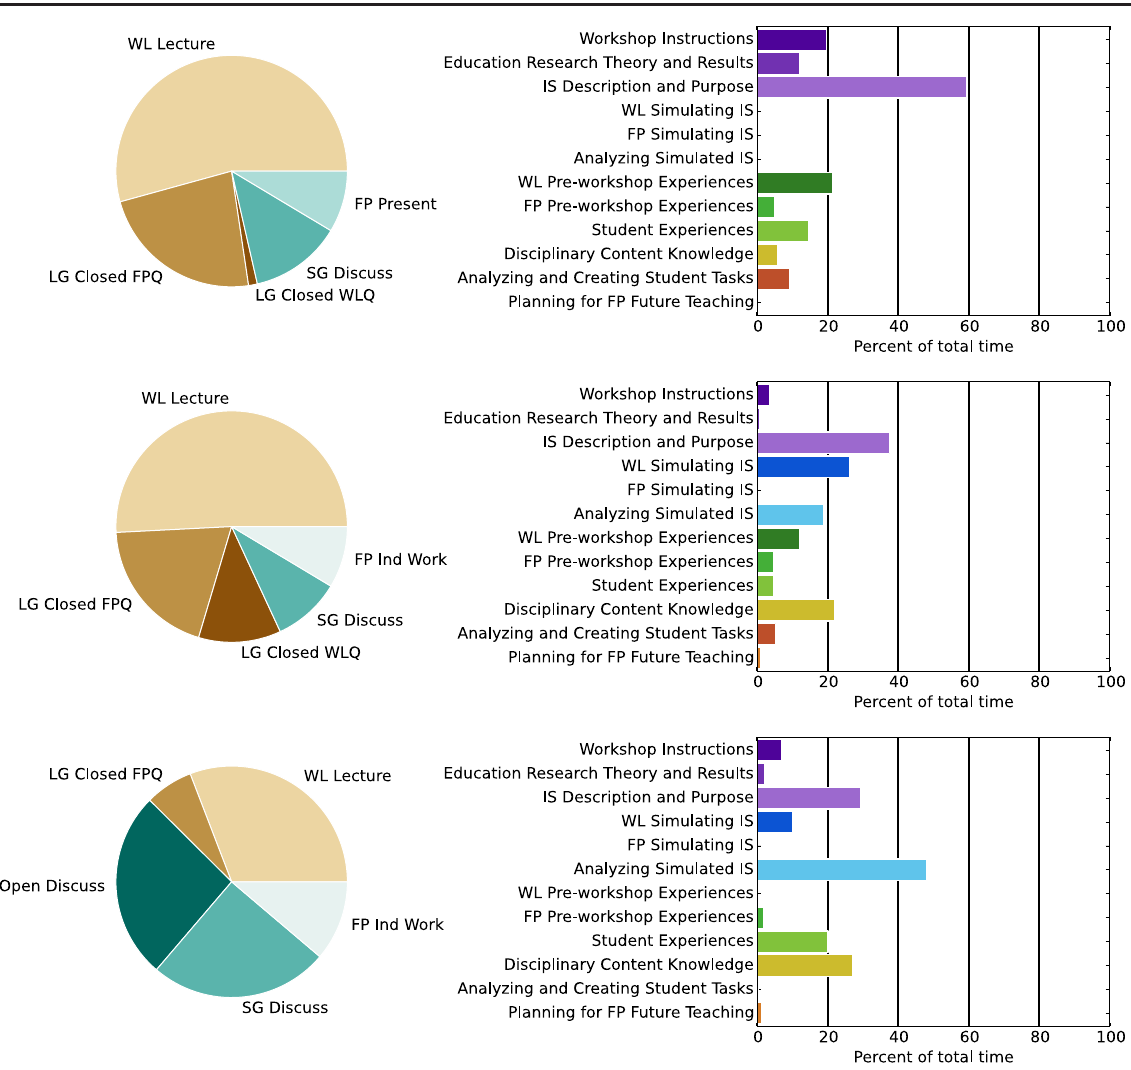
FIG. 2. Summative plots showing how much time was spent enacting each R-PDOT code during three approximately 1-h long sessions of the Physics and Astronomy New Faculty Workshop, labeled A , B , and C . The pie charts show the type of faculty ’ s engagement as defined in Table I, where authoritative communicative approaches are shown in brown and dialogic approaches are shown in teal; the bar charts shows the focus of faculty ’ s engagement as defined in Table III. Further discussion of the color scheme can be found in Sec. V